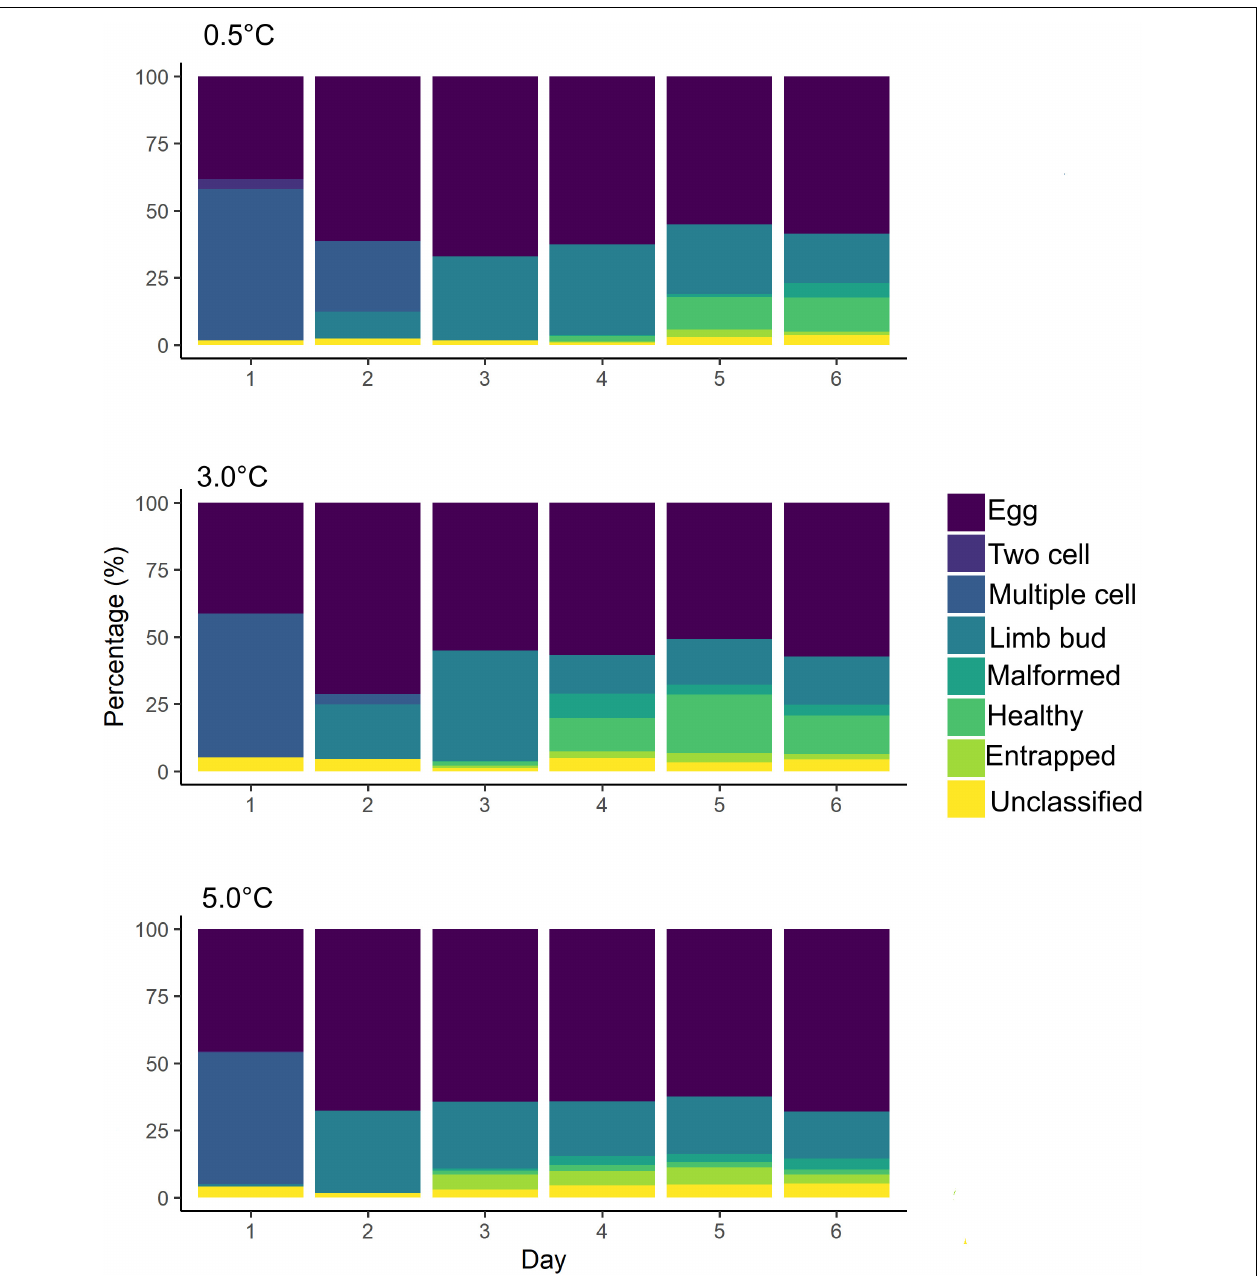
FIGURE 6 | Rate of embryonic development. The rate of embryonic development from each of the temperature treatments in our field experiments. Each of the recorded embryonic development stages is shown in a different color. For each day of the experiments, the mean percentage of each developmental stage is